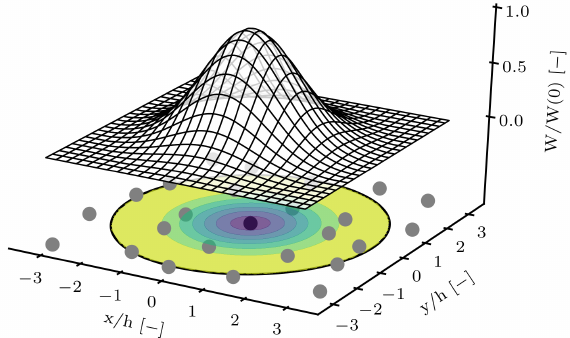
Figure 2. Top: Illustration of a 2D kernel. Bottom: Particle distribution superimposed with the kernel weight and illustration of the sphere of